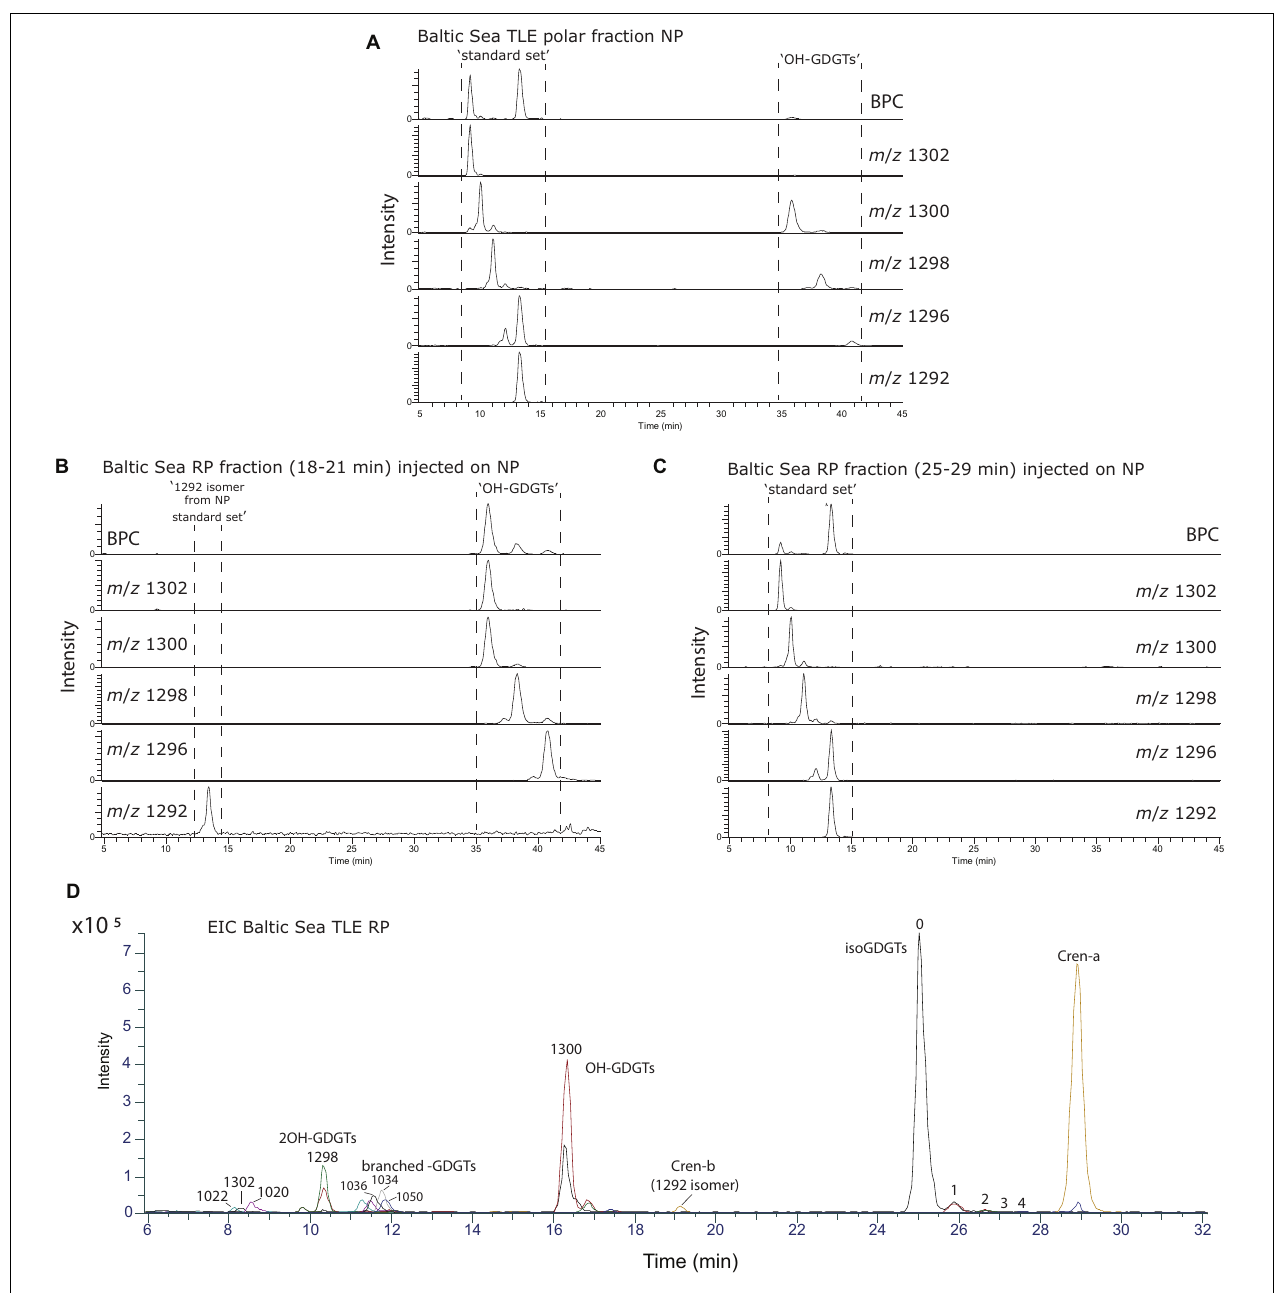
( Figure 3A ), brGDGTs elute later than the isoprenoid GDGTs and this is converse for the RP analysis ( Figures 3B–D ) as previously reported by Zhu et al. (2013) for RP chromatography. The tetramethylated (I) elute before the pentamethylated (II) and hexamethylated (III) homologs in RP, in contrast to the NP method where the order is III-II-I. Using a longer NP